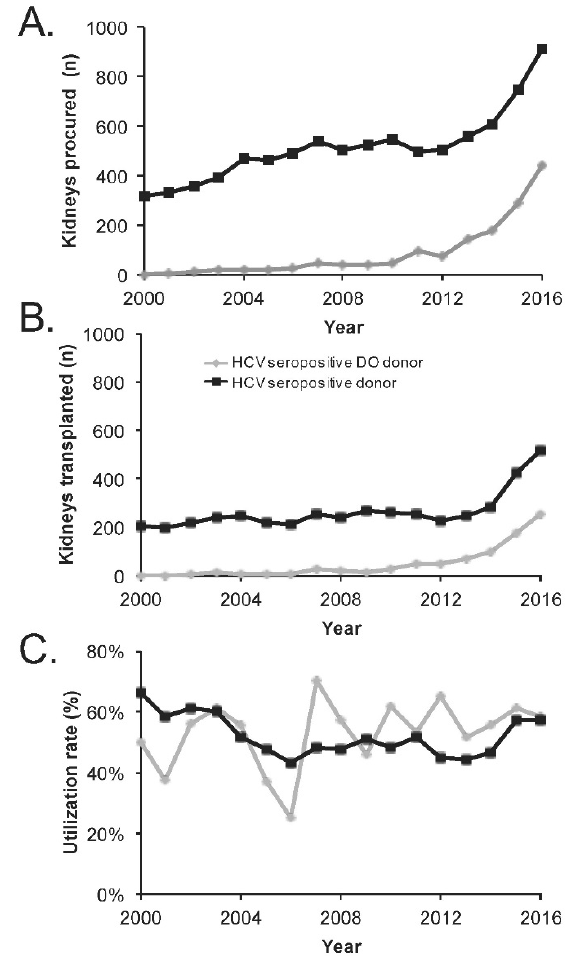
Figure 2. Trends in kidney utilization from HCV seropositive and drug overdose donors. ( A ) Kidneys procured from all HCV seropositive donors and from HCV seropositive donors with drug overdose as the mechanism of death; ( B ) Kidneys transplanted from the same populations; ( C ) Utilization rate of kidneys procured from the same populations. DO = Drug Overdose as the mechanism of death.